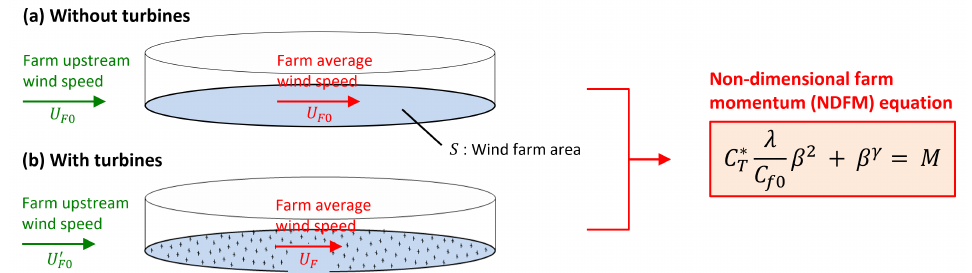
Figure 1. Schematic of a control volume containing the whole area of a large offshore wind farm (for the case with and without